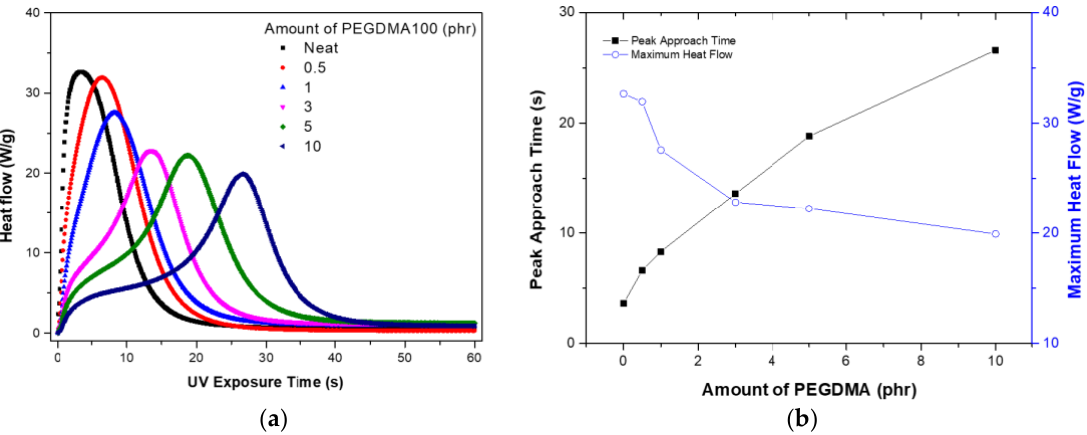
Figure 4. Photodifferential scanning calorimetry (photo-DSC) results for a UV-curing system obtained using poly (ethylene glycol) dimethacrylate with an intermediate molecule size of 100 (PEGDMA100): ( a ) real-time heat flow; ( b ) peak approach time and maximum heat flow.